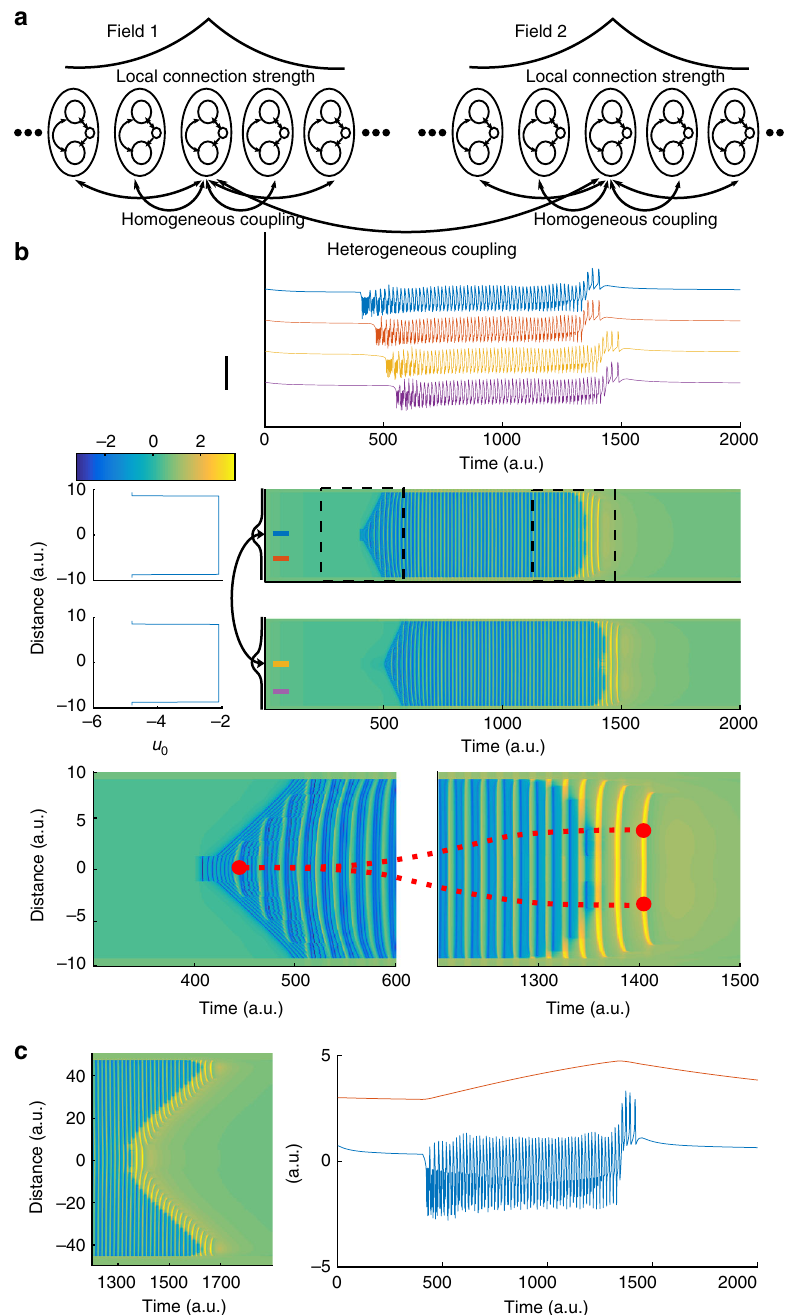
Fig. 2 The Epileptor fi eld model reproduces multiscale features of spatiotemporal seizure dynamics. a Schematics for the Epileptor fi eld model. At each spatial location of the neural fi eld, an Epileptor site (oval) includes two neural populations and a slow permittivity variable (inner circles). Epileptors are connected to their neighbors via local homogeneous coupling, which decays exponentially with pairwise distances. Epileptors also connect to Epileptors in other fi elds through heterogeneous coupling. b Simulation of a model including two distant Epileptor fi elds (middle plot). The top fi eld includes the seizure onset area, while the bottom fi eld represents a more distal brain area. Spatial values for excitability parameter ( u 0 ) and simulated spatiotemporal activity are shown on the left and right, respectively. For simplicity, we chose a constant spatial pro fi le for u 0 , except for the regions close to the fi eld boundaries, which represent brain regions with low excitability that are not recruited into the seizure. The curved arrow indicates heterogeneous connections between the two fi elds. The connection kernels (black lines) were centered at the indicated locations. The seizure started in the top Epileptor fi eld, slowly propagated throughout the fi eld, then eventually recruited the bottom Epileptor fi eld, where it slowly propagated as well. The horizontal colorbar indicates the activity level for the middle and lower plots. Time series at four spatial locations in the two fi elds (indicated by colored bars in the middle plot) are shown in the top plot. Scale bar: 4 a.u. The two bottom plots show a zoomed in view of the spatiotemporal activity at seizure onset (left) and offset (right). In this example, the seizure ended synchronously within each fi eld, with a few SWDs propagating after seizure offset. Red dots mark the source location of the propagating SWDs at seizure onset and offset. As the seizure evolved, the source of SWDs changed along with the slow ictal wavefront across each fi eld. c Left: Asynchronous seizure termination; in this case the recruitment delay was large enough in comparison to the seizure duration; Right: Corresponding activity ( − u 1 + q 1 , blue) and the slow permittivity variable ( v , red) at the seizure onset site (location zero in the fi